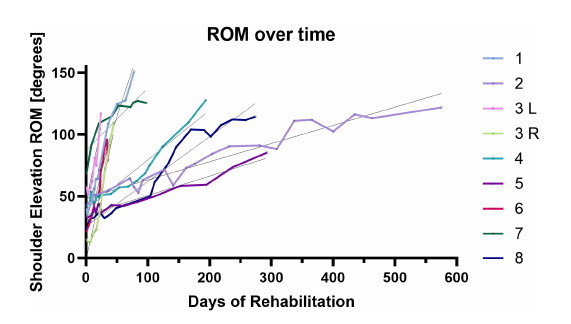
FIGURE3 Evolution of ROM of shoulder elevation angle over sessions and linear